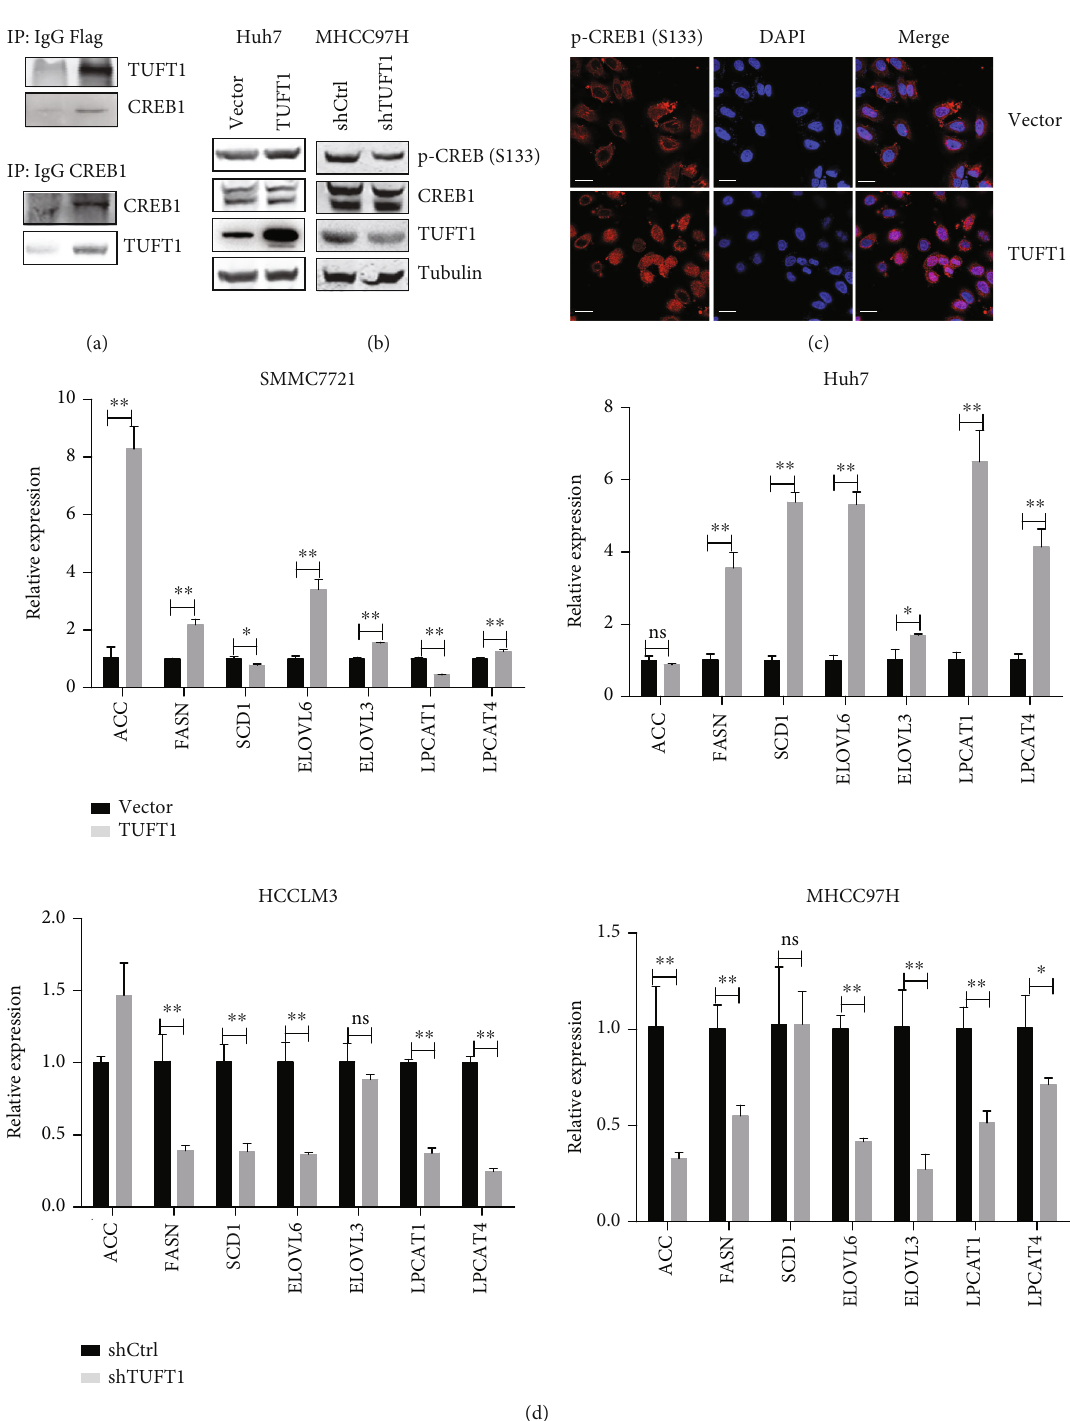
Figure 4: TUFT1 was associated with CREB1 and promoted its phosphorylation and nuclear translocation. (a) Co-IP of TUFT1-Flag with an anti-Flag antibody (upper panel), or with an anti-CREB1 antibody (down panel), followed by western blot analysis in Huh7 cells. (b) Western blot analysis of phospho- and total CREB1 in TUFT1-overexpressing or knockdown cells. (c) Immuno fl uorescence analysis of localization of phospho-CREB1 in TUFT1-overexpressing Huh7 cells. Scale bar: 20 μ m. (d) mRNA expression levels of lipid de novo synthesis enzymes semiquanti fi ed by qRT-PCR, using β -actin as an internal control. ns: no signi fi cance; ∗∗ P < 0 : 01